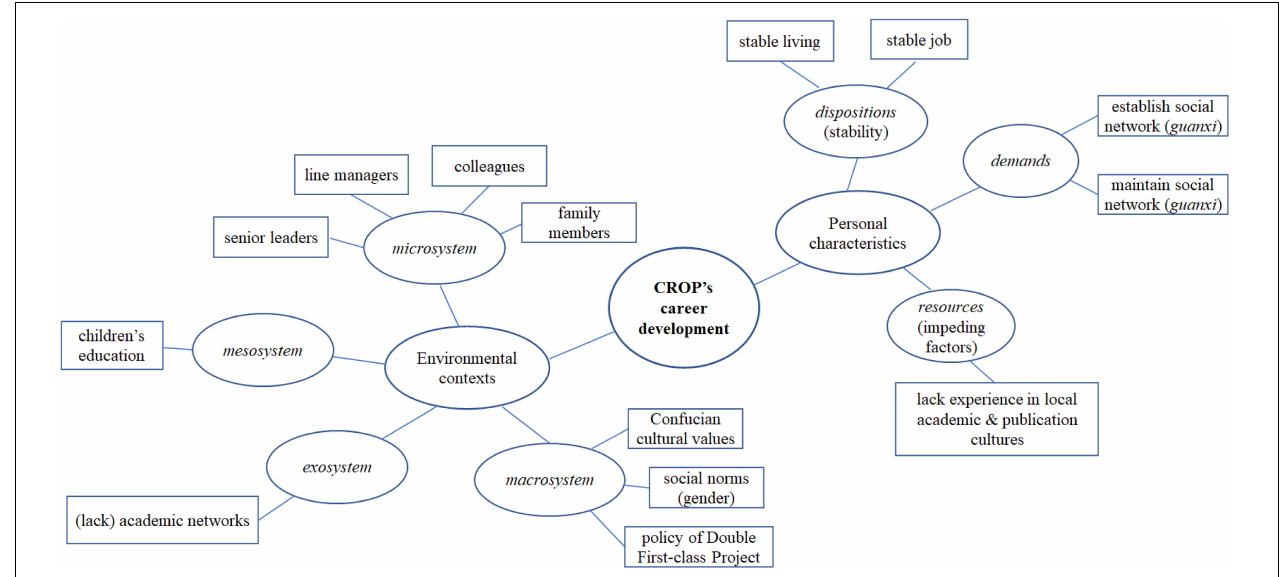
FIGURE 1 | Final thematic